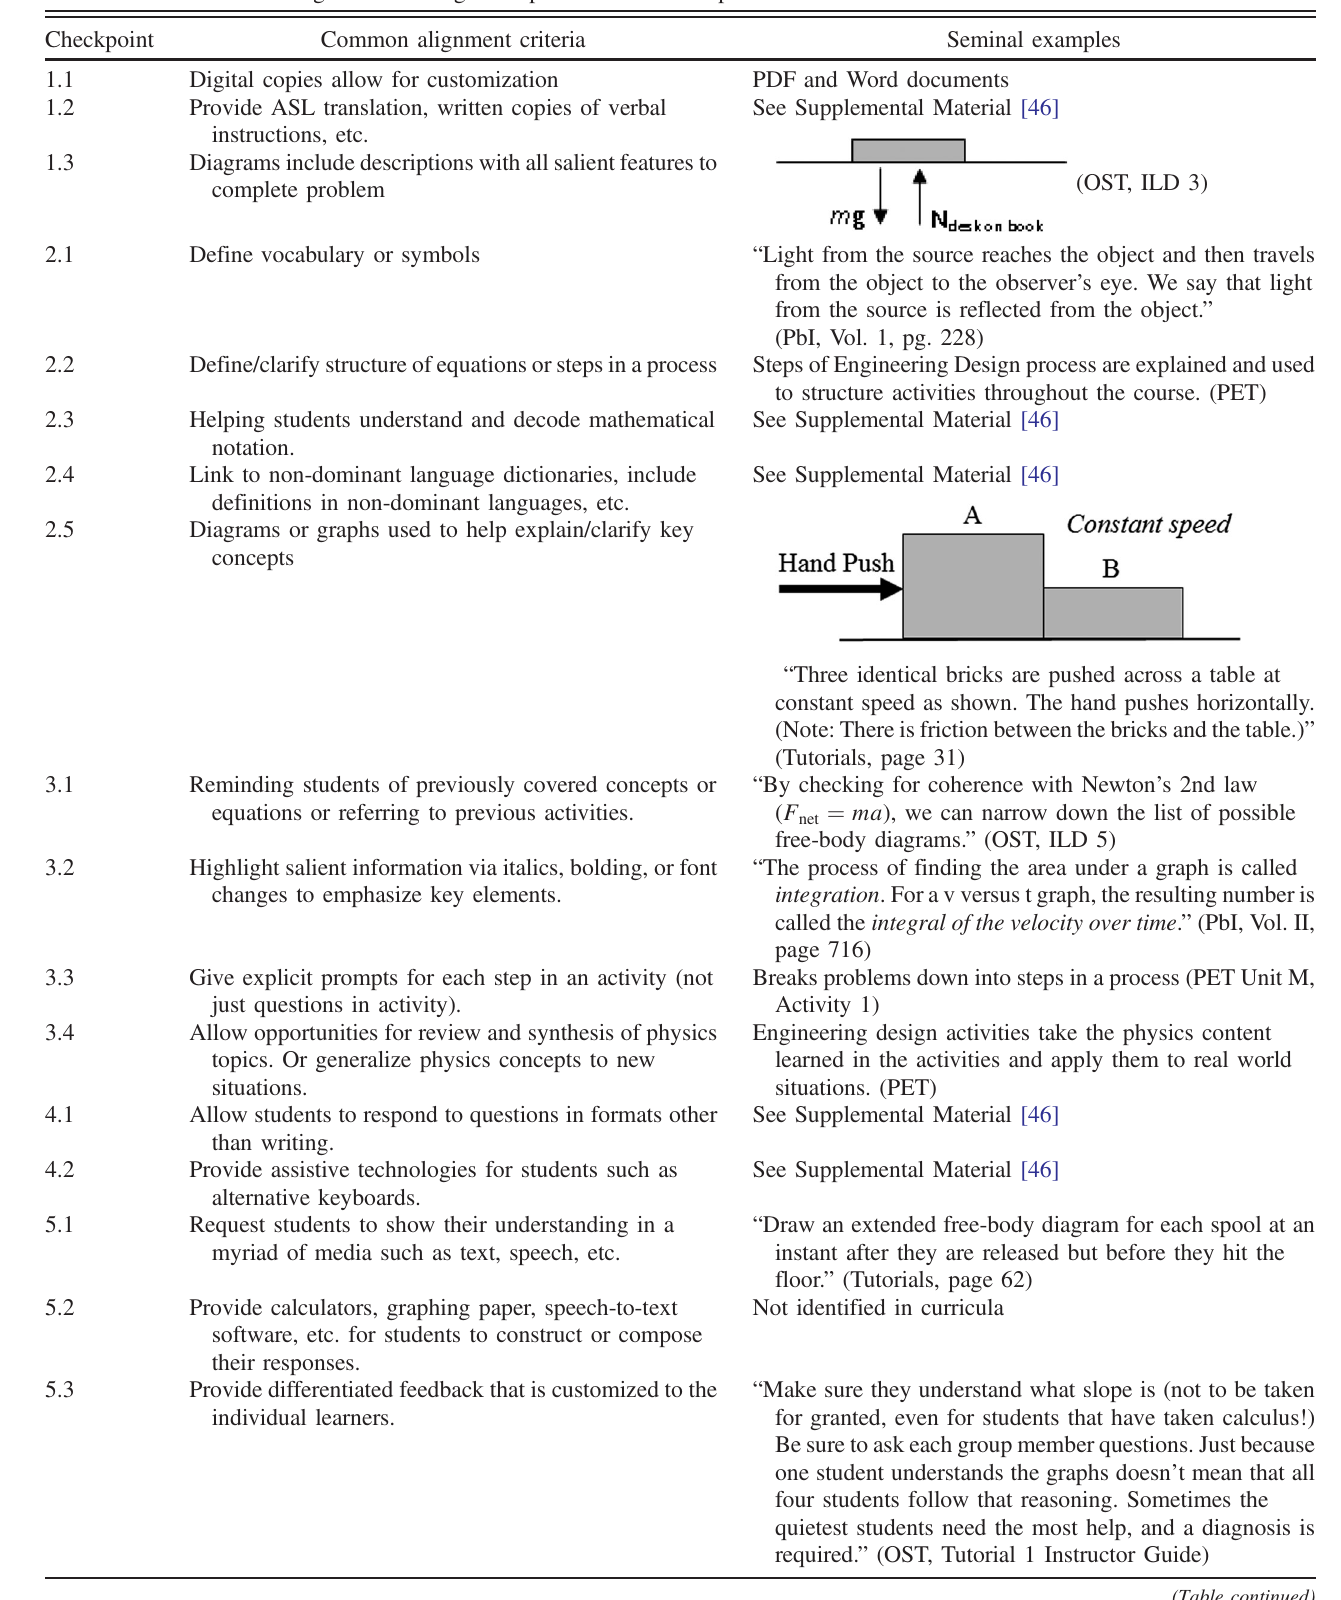
TABLE V. Universal Design for Learning checkpoint seminal